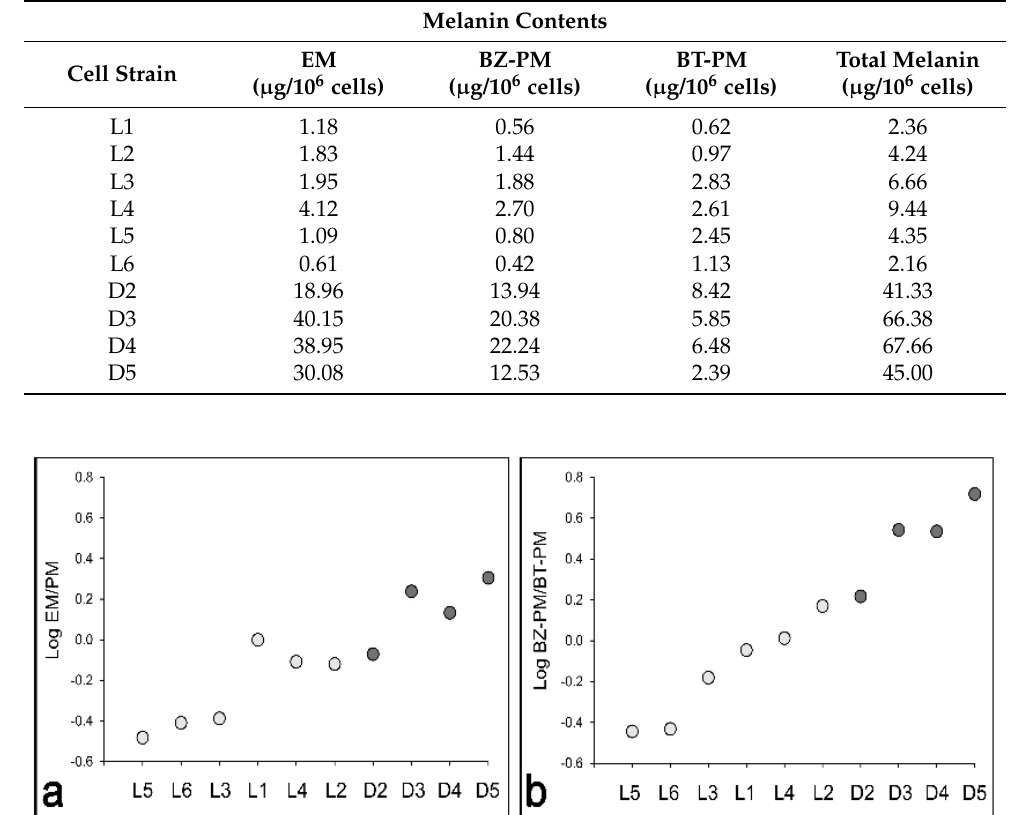
Table 1. Quantitative analysis of basal Eumelanin (EM), BZ-pheomelanin (BZ-PM), BT-pheomelanin (BT-PM), and total melanin in light (L) versus dark (D) melanocyte cultures. Each data point is the mean of duplicate samples.